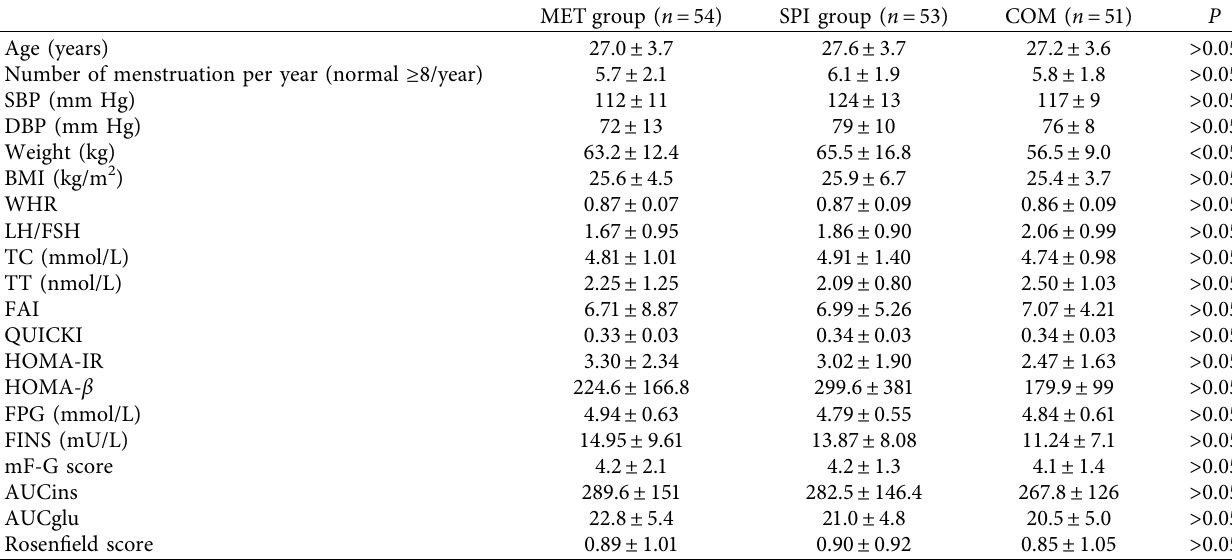
Table 1: Baseline characteristics of the participants.